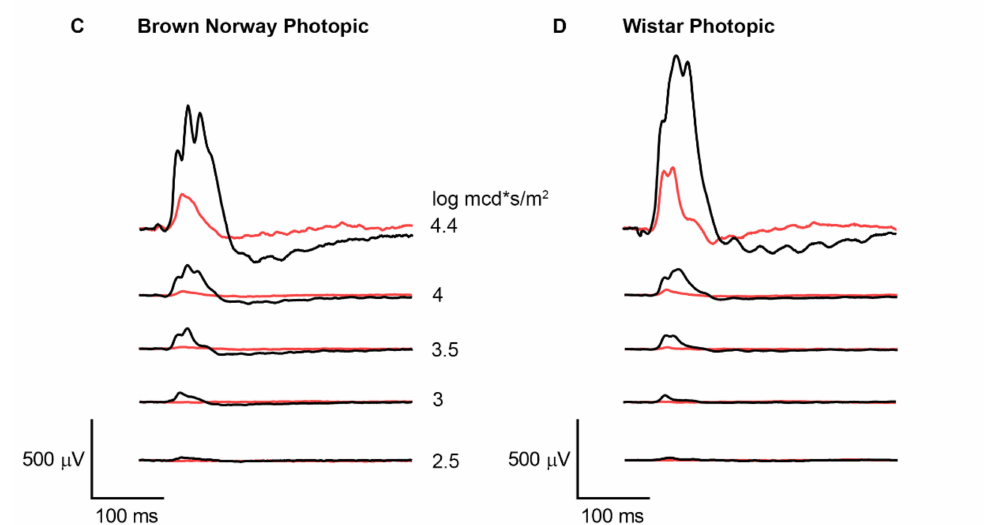
Figure 1. Representative electroretinogram (ERG) traces. ERG traces from a Brown Norway ( A , C ) and a Wistar ( B , D ) rat stimulated with white light (black trace) and monochromatic red light (red trace). Red light evokes a scotopic ( A,C ) and photopic ( B,D ) outer retinal response comparable in shape to white-light responses but of smaller